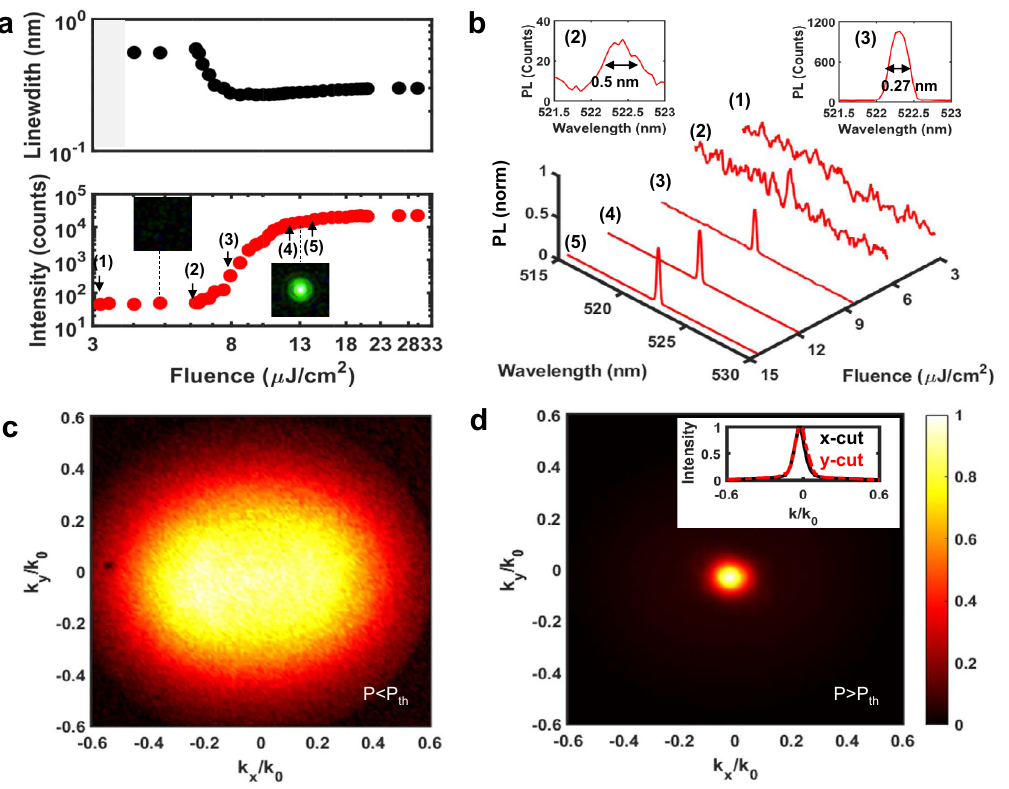
Fig. 4 | Laser performance of the 1D topological microlaser at room tempera- ture. a Light-lightcurveof themicrolaserandlinewidthoftheemissionspectraasa functionofthepump fl uenceatroom-temperature.Theshadowregionindicatesthe unde fi ned linewidth due to low pump fl uence. The insets illustrate representative imagesofthebeampro fi lesmeasuredatthesamplesurface,belowandabovelasing threshold. b Room-temperature emission spectra of the topological microlaser as a